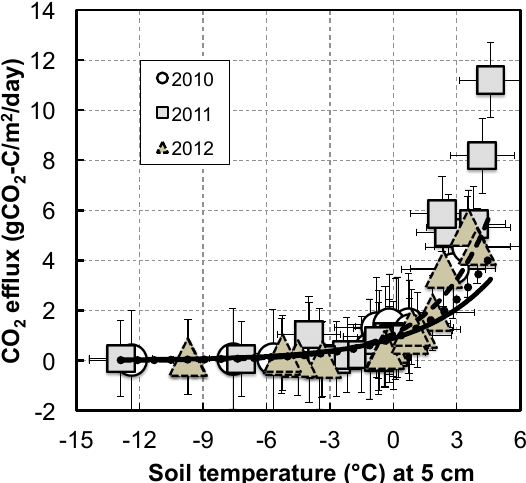
Figure 7. Spring CO 2 efflux responses to soil temperature at 5cm below the surface, across entire sites during the spring seasons of 2010 and 2012. Dashed, dotted, and solid curves show 2010, 2011, and 2012, respectively.